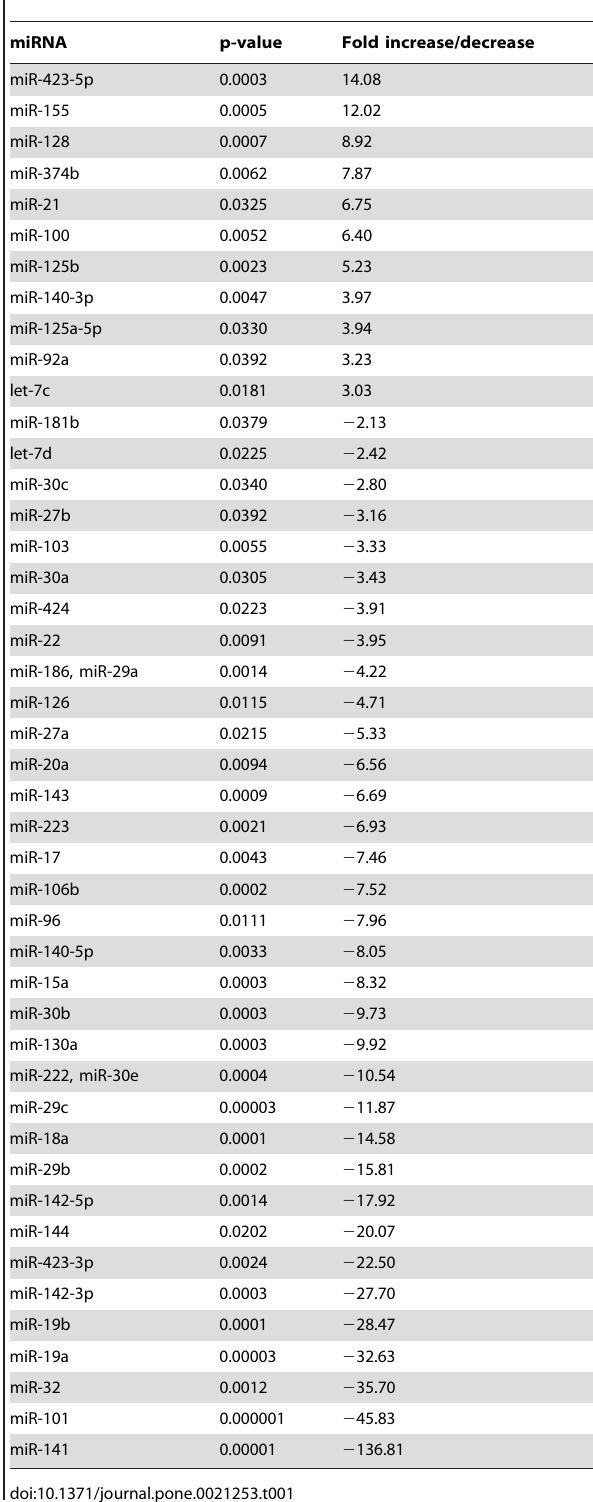
Table 1. List of increased and decreased miRNA in rapidly progressive IPF biopsies n =9) when compared to normal lung samples (n =10) with p #